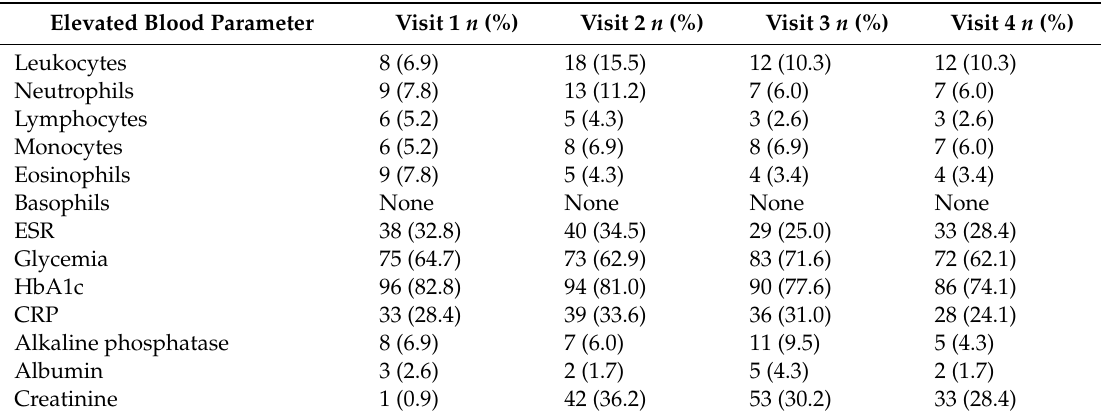
Table 3. Blood test—elevated blood